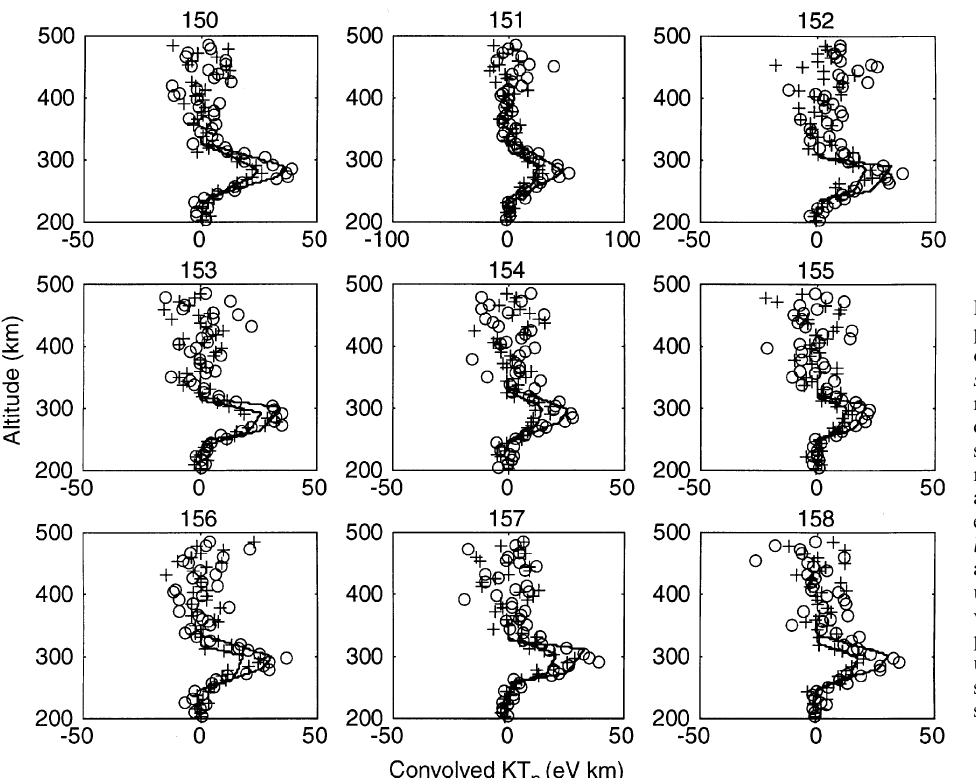
Fig. 2. Altitude profiles of plasma line intensity at 6.4 Mhz on 6 August 1990. The ‘ # ’ signs denote the upshifted sig- nal, and the ‘ (cid:115) ’ denote the downshifted signal. The mea- sured signal is multiplied with nominal gate range squared, and not compensated for differ- ent receiver gains. The solid lines are least square fits of a theoretical function [a single, uniform scattering range con- volved with a 54 km (360 (cid:108) s) pulse, and compensated for the use of nominal gate range to the scattering region in the mea- sured